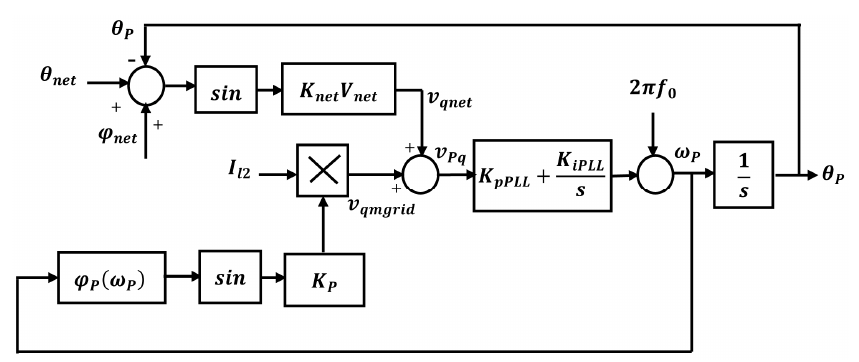
Figure 7. Block diagram of PLL, affected by network and micro-grid side factors.